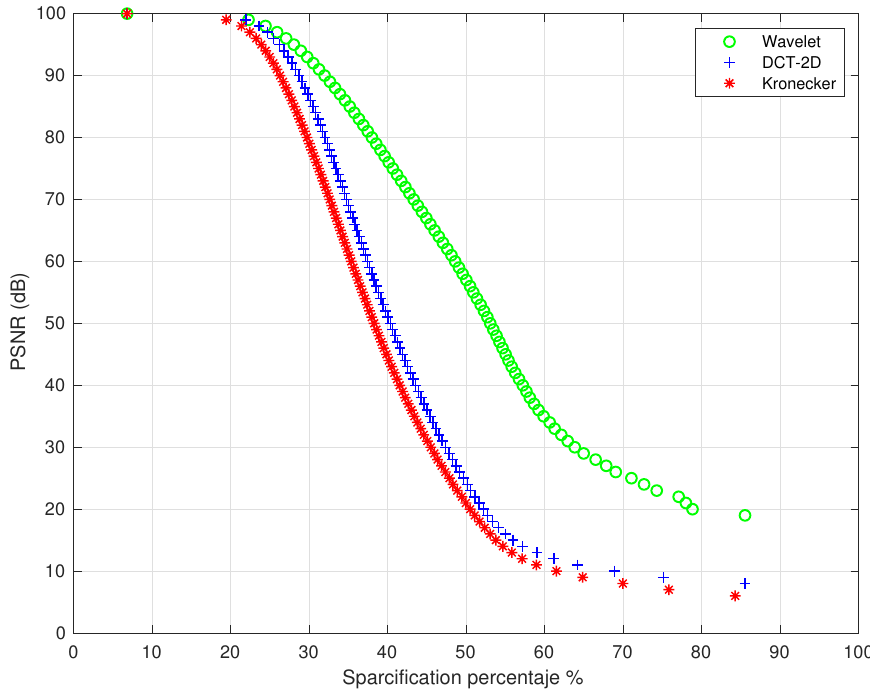
Figure 2. PSNR values vs sparcity